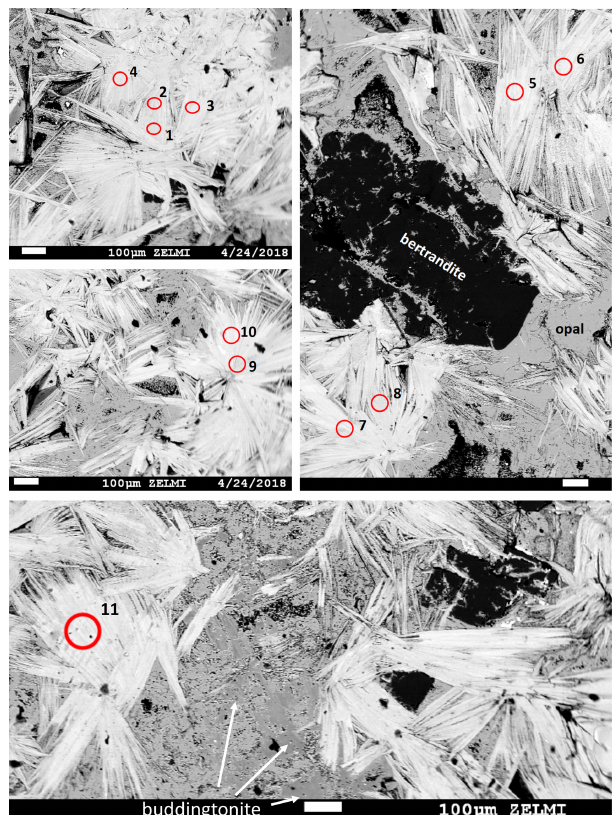
Figure 3. BSE images of polished pieces of sample V2008b, of the muscovite-rich part of the pseudomorph, prepared for irradiation. Numbered circles indicate sites of laser-ablation spots (see Table 1; test runs 1, 2, and 3 are not marked). White lath-shaped crystals are muscovite; difference in BSE contrast is due to a small tobelite com- ponent in slightly greyer crystals, together with bertrandite (black), buddingtonite, and opal (gray). Scale bar is 100µm in all